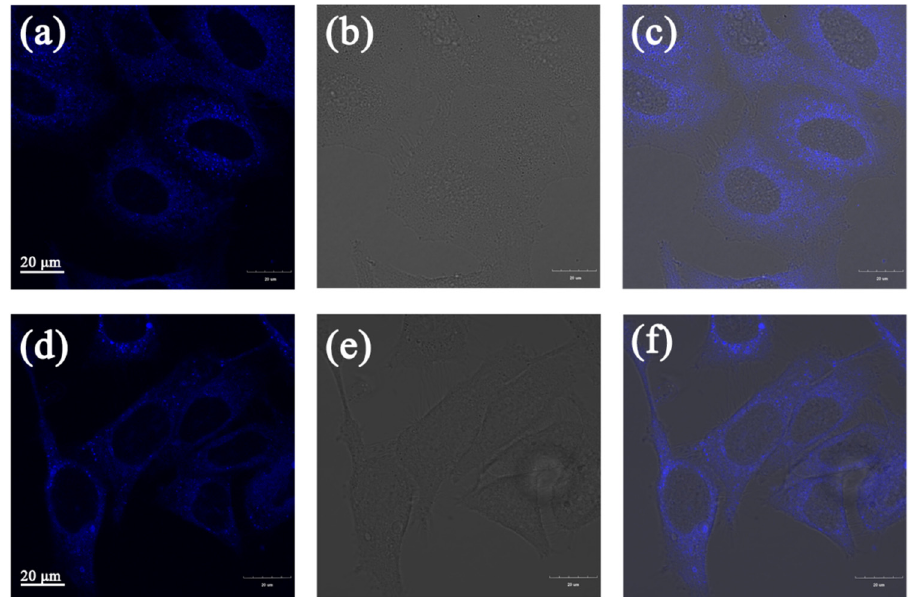
Figure 6. ( a ) The fluorescence image of compound 1 in A549 cells. ( b ) The bright-field image. ( c ) The merge image of ( a ) and ( b ). ( d ) The fluorescence image of compound 2 in A549 cells. ( e ) The bright-field image. ( f ) The merge image of ( e ) and ( f ). The excitation wavelength was 359 nm. The collected wavelength range was 430–480 nm.